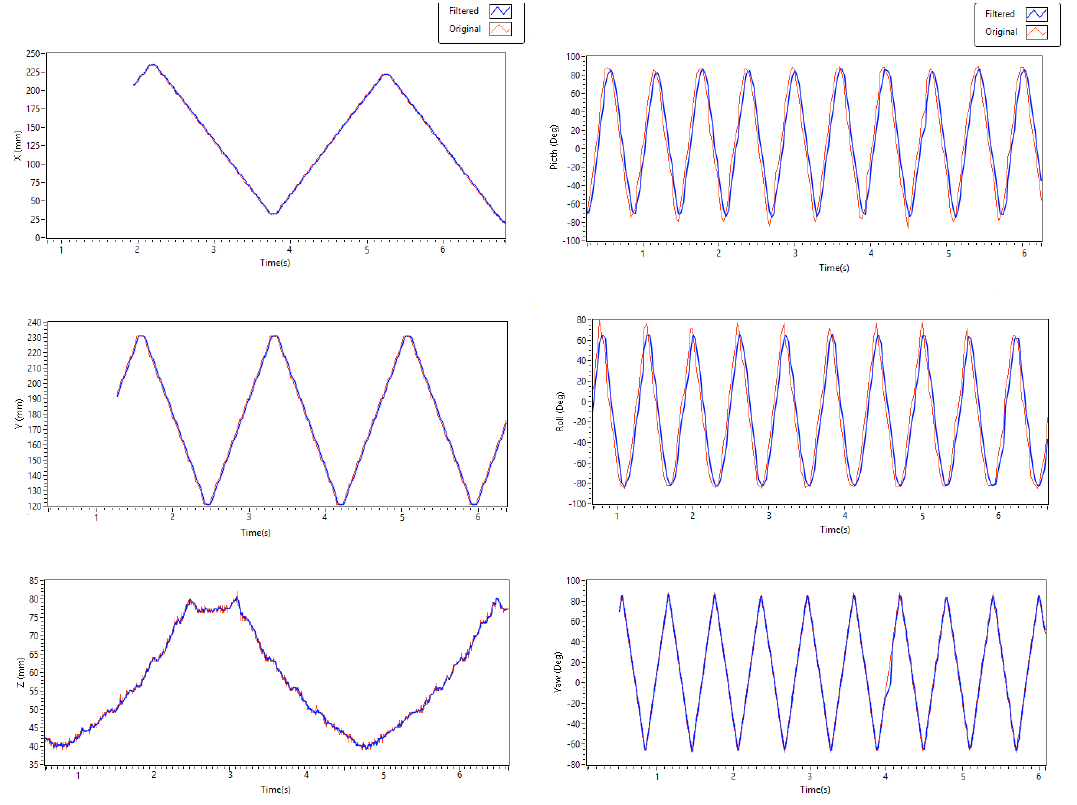
Figure 7. Position and orientation dynamic accuracy